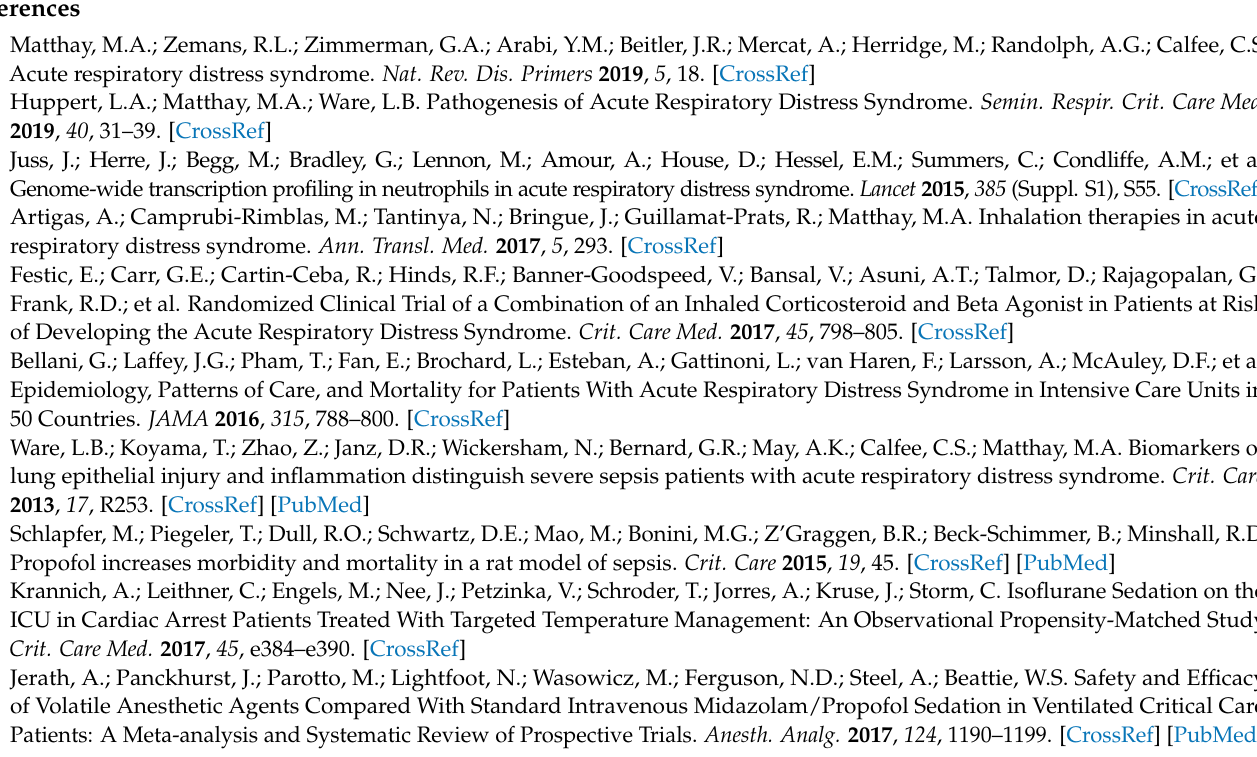
occludin; Figure S2: Effects of sevoflurane von CD39, CD73, adenosine receptor A1 (Adora1), and Adora3 during acute pulmonary inflammation; Figure S3: Impact of sevoflurane on zonula occludin-1 (ZO-1) expression in the lung tissue of wild-type and adenosine A2B receptor − / − (Adora2b − / − ) animals; Figure S4: Effects of sevoflurane on occludin expression in the lung tissue of wild-type and adenosine A2B receptor − / − (Adora2b − / − ) mice during lipopolysaccharide (LPS)-induced acute inflammation; Figure S5: Heme oxygenase-1 (HO-1) and adenosine A2B receptor (Adora2b) expression after sevoflurane